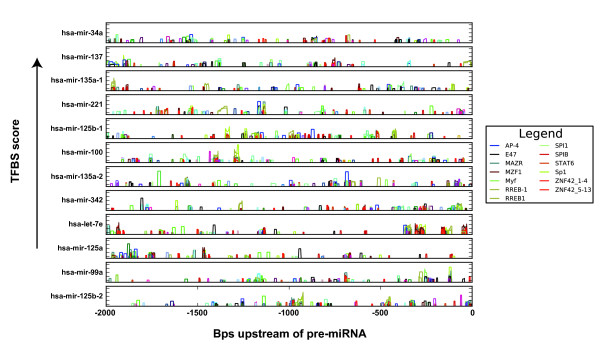
Representation of TFBSs in promoter regions of miRNAs up-regulated in DCs. Depicted are the TFBSs at a motif instance score threshold of at least 6 in the miRNA promoter regions. The scale of the y-axis ranges from 5 to 15 for each subgraph. The legend shows only those TFBSs that are present in all promoter sequences.